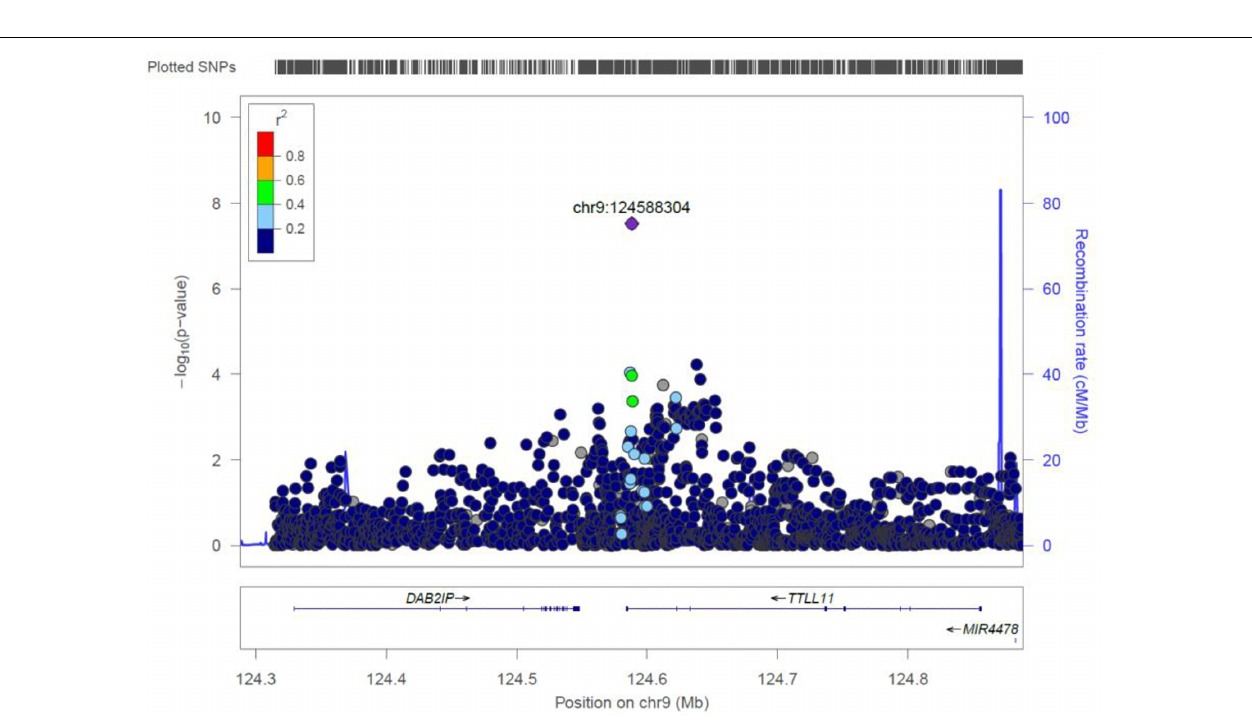
FIGURE 8 | Regional visualization of the GWAS of –log10 of the P -value of genomic location TTLL11 (rs4837892 in purple), with each dot representing a SNP on the corresponding genes at the bottom.